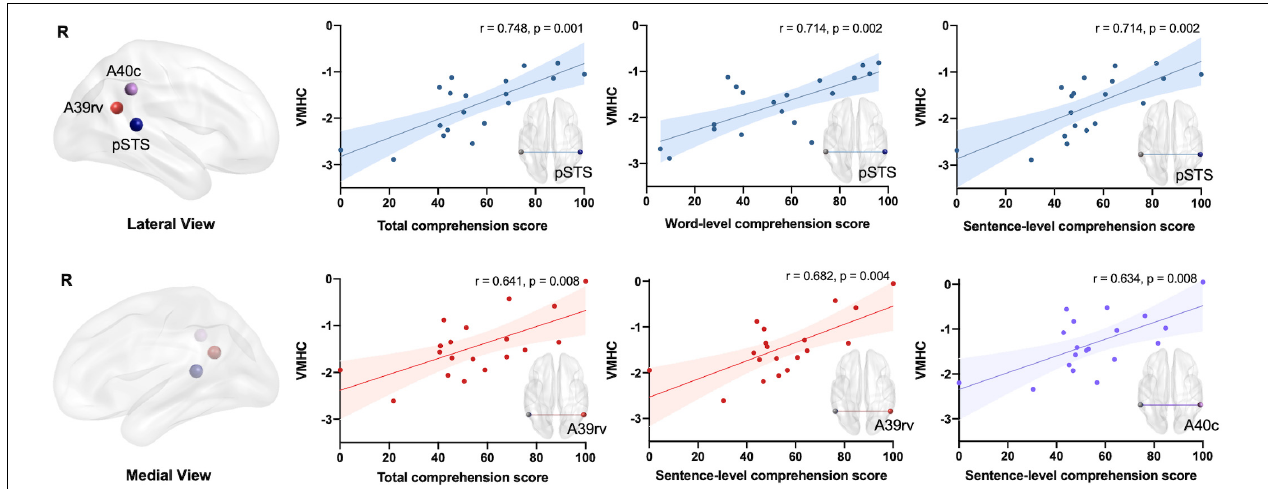
FIGURE 4 | Associations between speech comprehension and regional interhemispheric homotopic connectivity in patients with post-stroke aphasia after controlling for age, sex, education level, and lesion size (FDR-corrected p < 0.05). Colors indicate different brain regions: blue for pSTS, red for A39rv, and purple for A40c. A39rv, rostroventral area; A40c, caudal area 40; pSTS, posterior superior temporal sulcus; VMHC, voxel-mirrored homotopic connectivity.